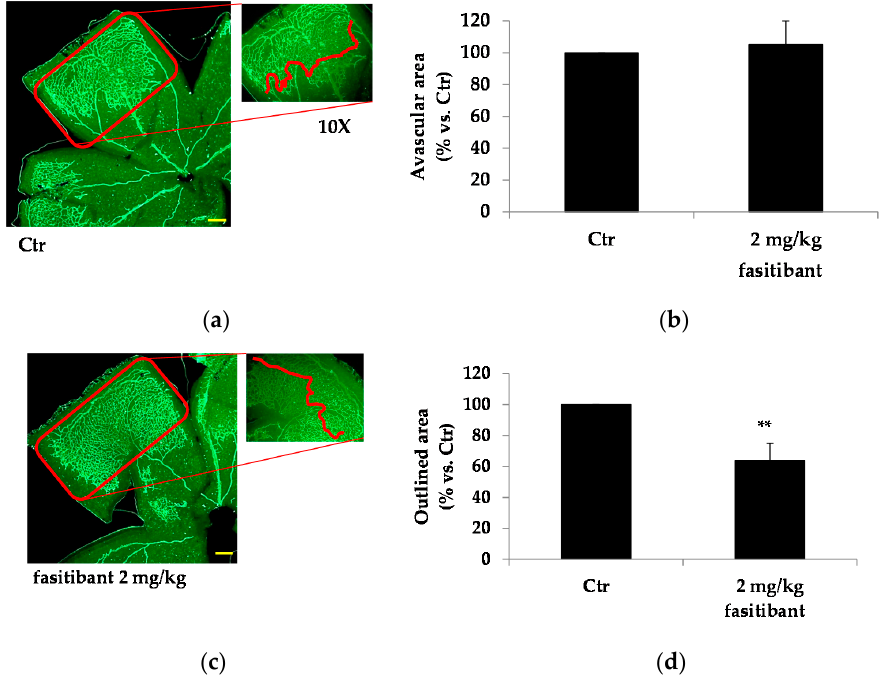
fasitibant treated. Left panels: magnification 4 × , scale bar = 100 μ m; Right panels: magnification 40 × ;